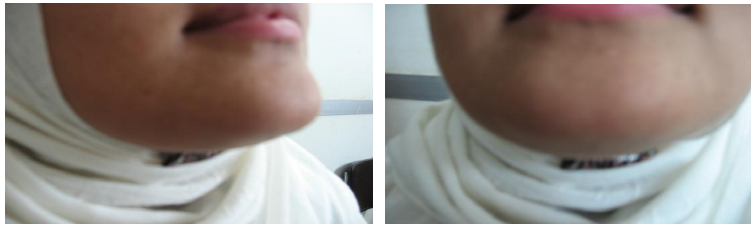
Fig (15-B) A case of acne GAAS